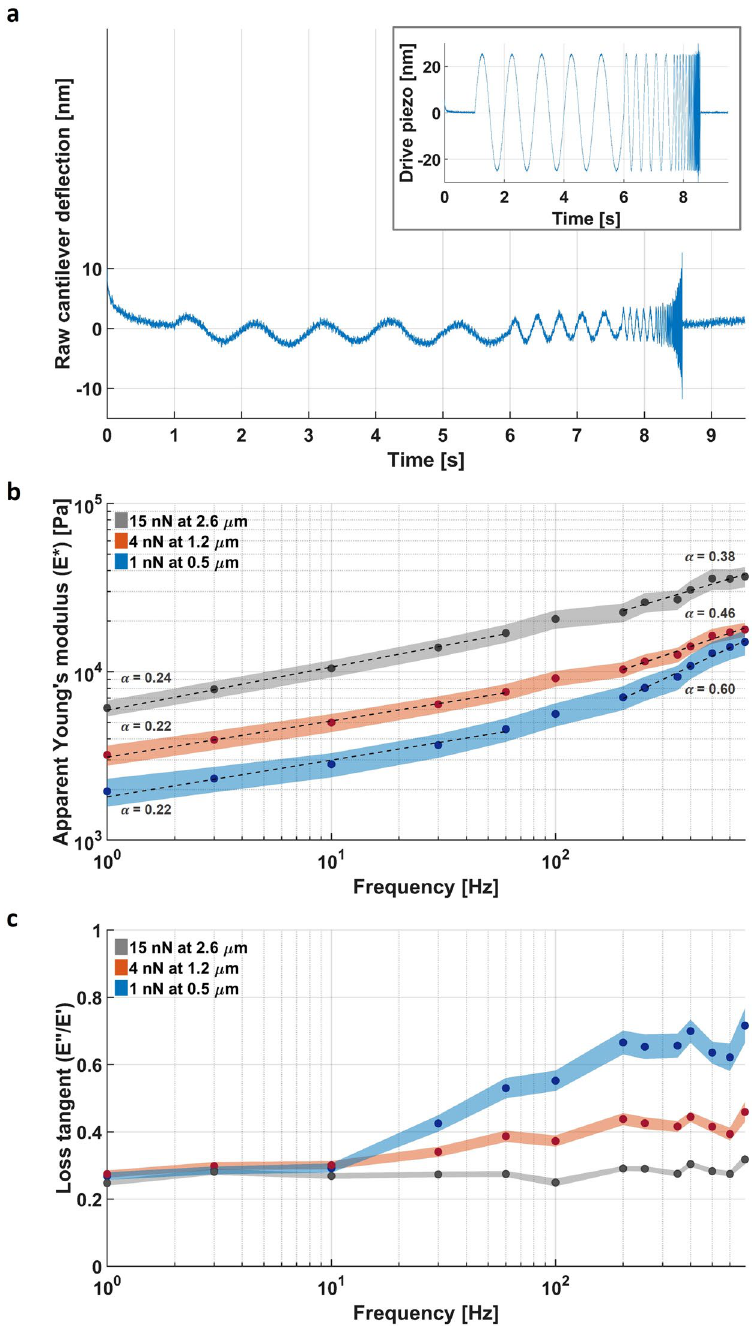
Figure 2. Measuring the response of the nucleus at different deformation length- and time-scales. ( a ) Inset shows the motion of the piezo-element that moves the base of the cantilever with increasing frequencies at a constant amplitude of 25 nm. The main panel shows the cantilever bending at its free end. Higher bending means more resistance, which can be induced by the compliance of the nucleus but also by the drag of the surrounding buffer. The latter is corrected for in the analysis. ( b ) At low deformation rates of 1 Hz, E * is not constant but increases threefold when the indentation depth is increased from 0.5 to 2.6 µ m. At higher deformation rates up to 700 Hz, the dependency on the indentation remains. In addition, the modulus increases multi-fold with frequency. E * below and above the estimated threshold of 100 Hz had been fitted with a power law (dashed black line). The slope at low and high frequency are 0.22 and 0.60 at 1 nN, 0.22 and 0.46 at 4 nN and 0.24 and 0.38 at 15 nN. ( c ) The complex Young’s modulus can be decomposed in its viscous ( E ″ ) and elastic ( E ′ ) components. The ratio E ″ / E ′ (loss tangent), shows that the viscous contribution is small at high deformations and low frequencies. Only at small deformations and higher frequencies does the viscosity contribution becomes more pronounced. The data is shown as the mean ± standard error of the mean of the log transformed data (shaded